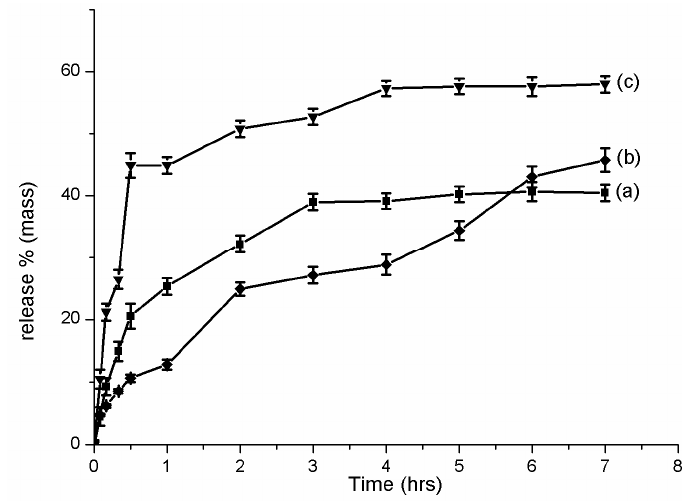
Figure 8. Release profile of pure VC-IP ( a ), VC-IP@SBA-15 ( b ), VC-IP@cyclodextrin ( c ).